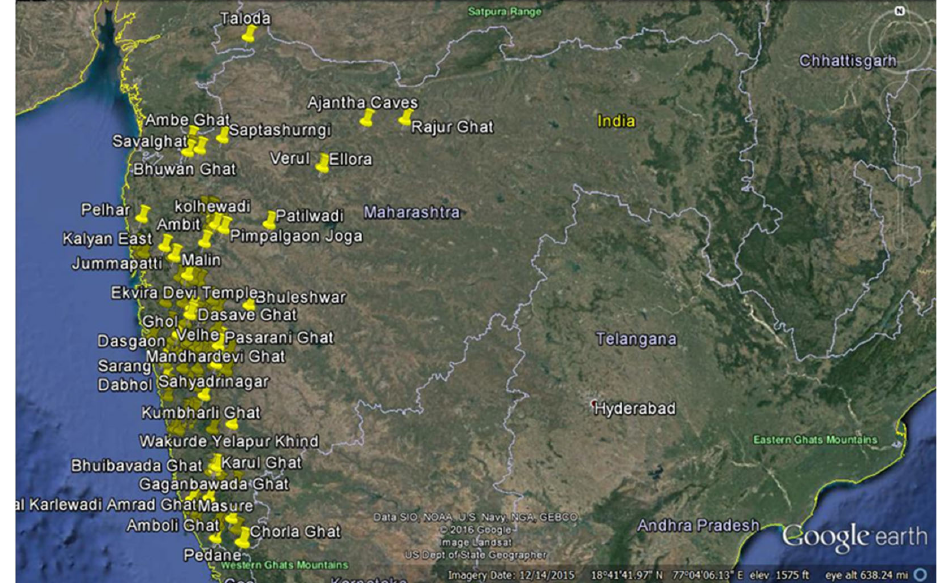
Figure 4. Locations (cities, towns, villages) of LS in the state of Maharashtra. Table 1. Locations of LS-prone sites in the Aurangabad region. The words windward, ILS and DLS indicate the locations of LS sites on the windward, immediate leeward and distant leeward sites, of the WG mountains, respectively.